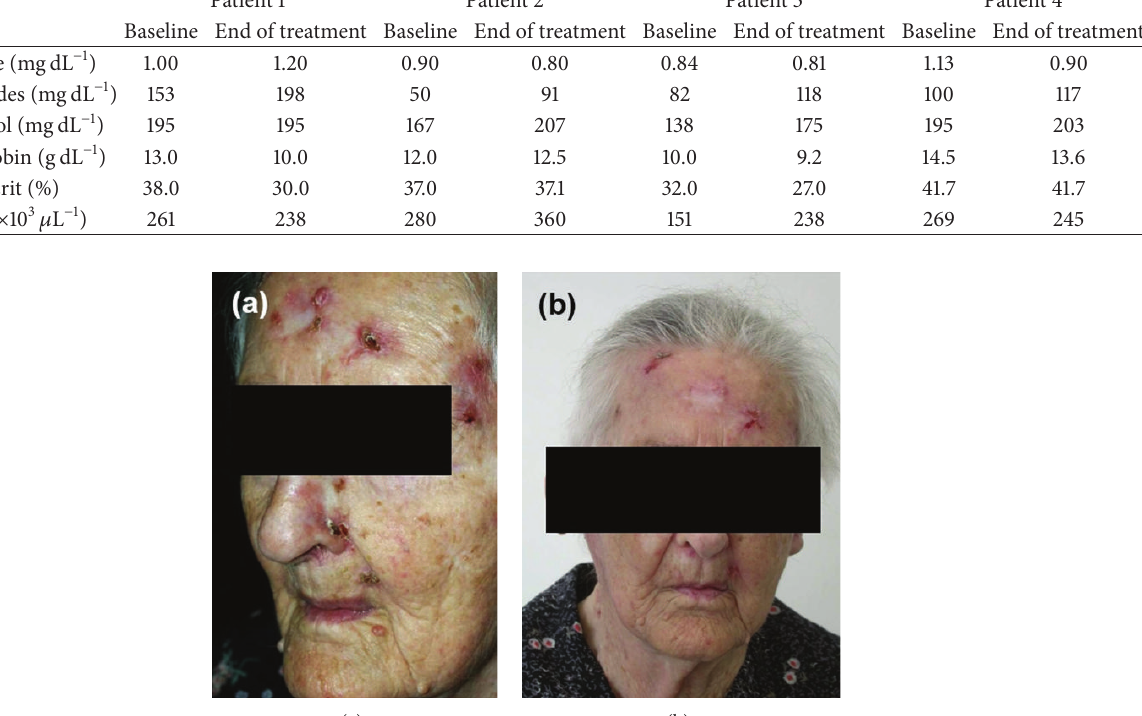
Table 1: Blood chemistry and haematology parameters assessed at baseline and end of treatment with everolimus. Patient 1